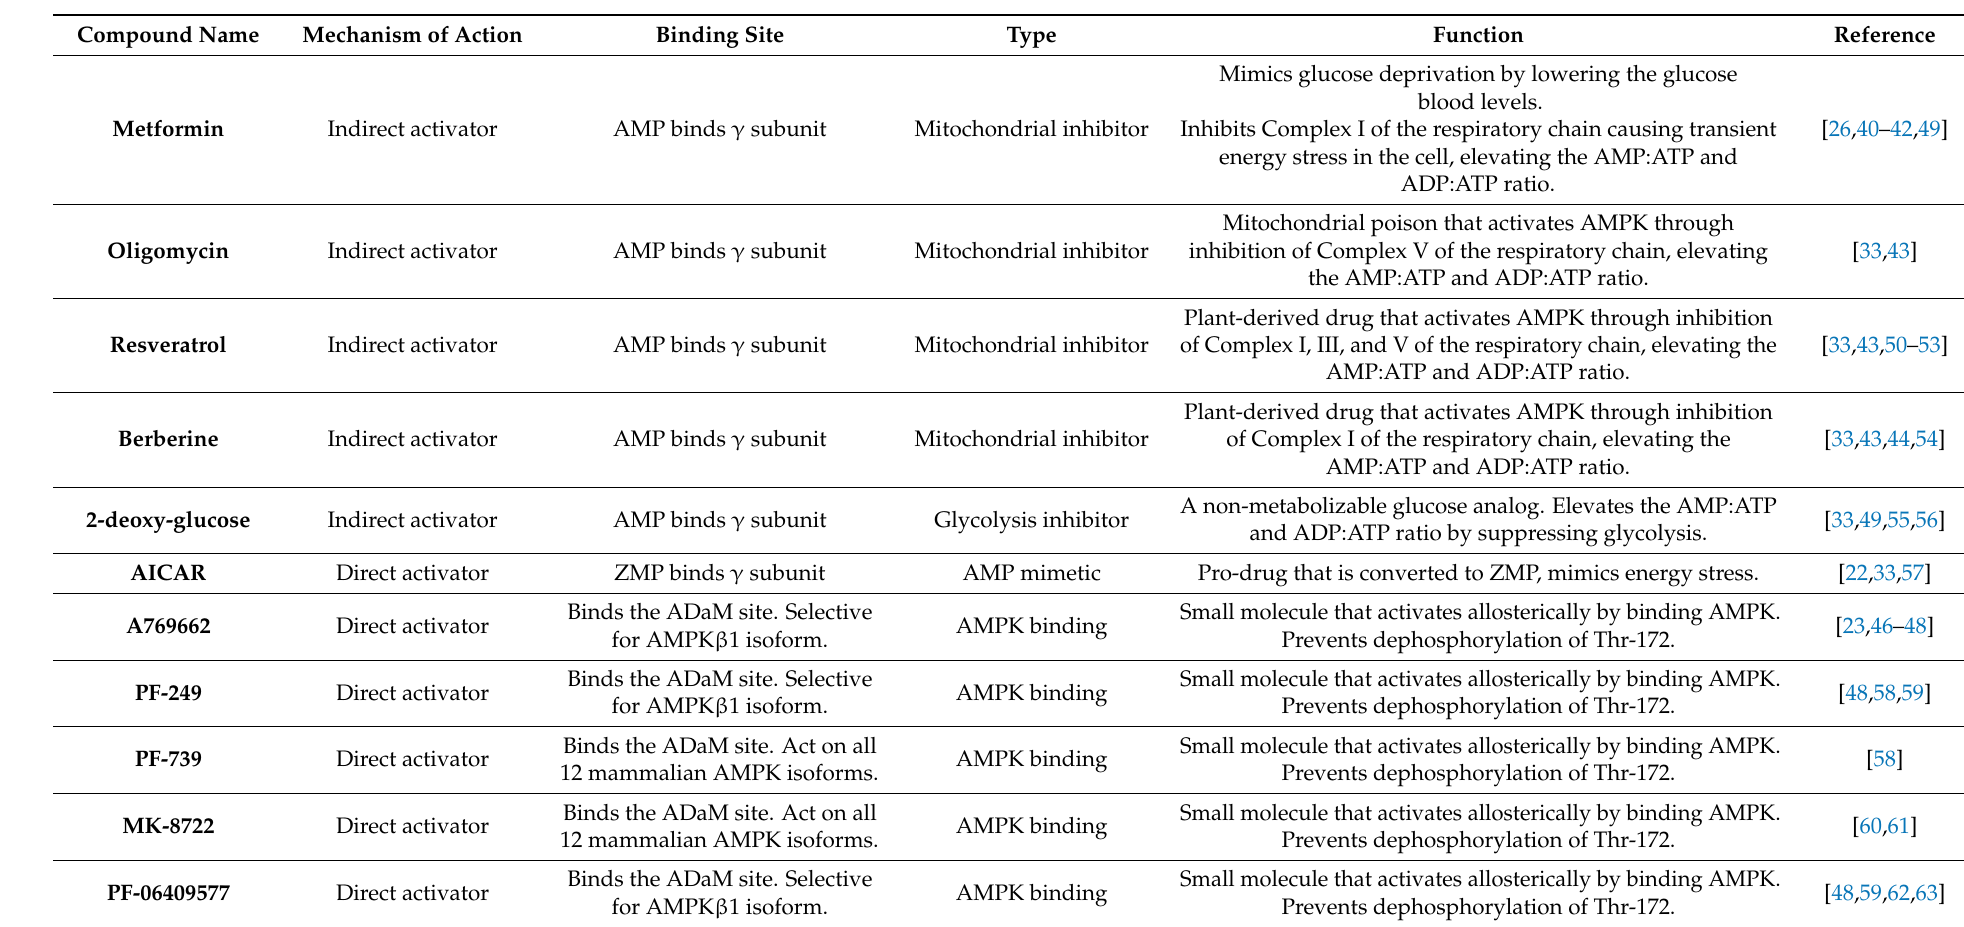
Table 1. Compounds that activate AMPK. Compounds can be divided into two classes of indirect activators and direct activators, depending on their mechanism of action and binding site [48]. Secondly, AMPK activators can be subclassified into mitochondrial inhibitors, glycolytic inhibitors, AMP mimics, and AMPK-binding